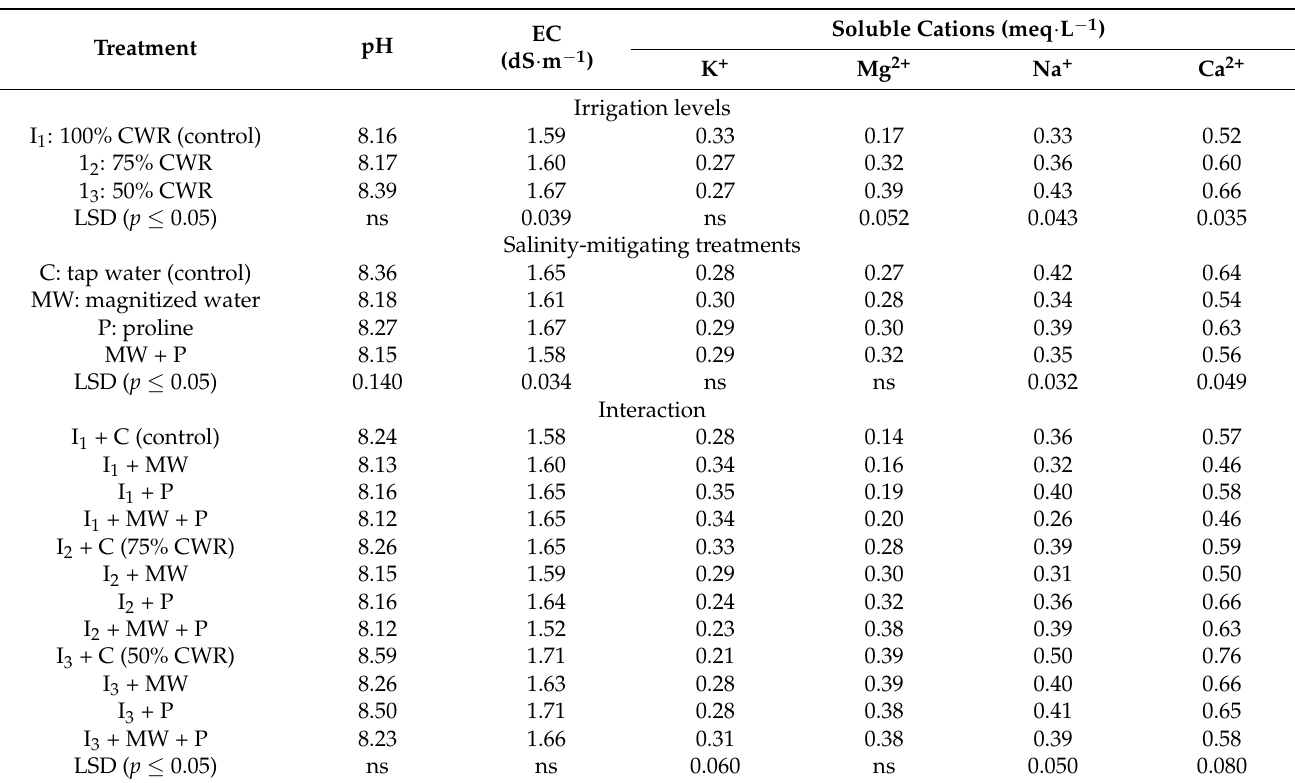
Table 8. Effect of MW, P, and MW + P on post-experiment soil chemical characteristics under different irrigation regimes (I 1 , I 2 , and I 3 ), based on CWR, during the 2019 and 2020 seasons.